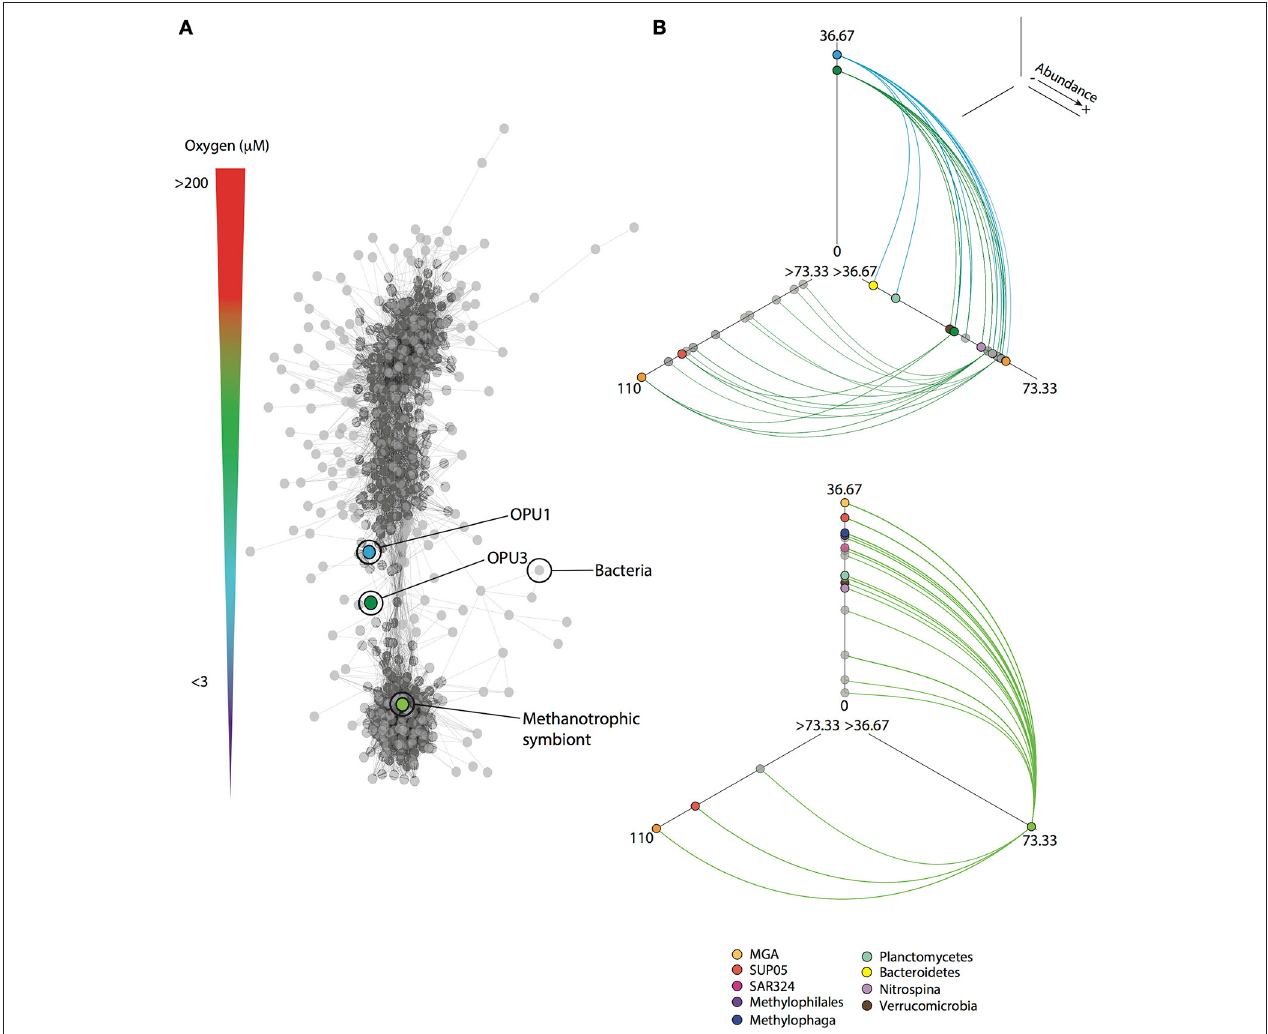
FIGURE 6 | Co-occurrence patterns for methanotrophic and indicator OTUs from SSU rRNA gene pyrotag datasets. (A) Network based on significant ( p < 0.001) Bray-Curtis and Spearman correlation values ( > 0.6) among OTUs that were present in at least 25% ( n = 72) of the total number of pyrotag samples ( n = 288). On top the oxygen gradient from oxic ( > 90 µ M O 2 ) to anoxic ( < 1 µ M O 2 ) is shown. (B) Hive panels for methanotrophic OPU1 and OPU3, and symbiont OTUs showing interactions with indicator OTUs (taxa colored as shown in key). OTUs are distributed based on abundance (log transformed) on the three axes from less abundant located closer to the center, to more abundant located toward the end of each line. Nodes are depicted according to taxonomy as indicated in network. All interactions (edges) are shown as solid lines. Direct interactions for methanotrophic OTUs to indicators are shown as solid colored lines in hive panels.